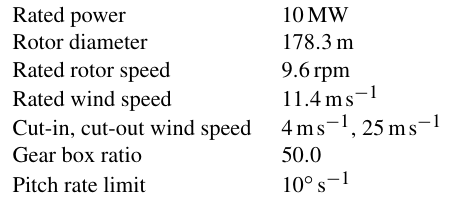
Figure 3. Cross-section definition.